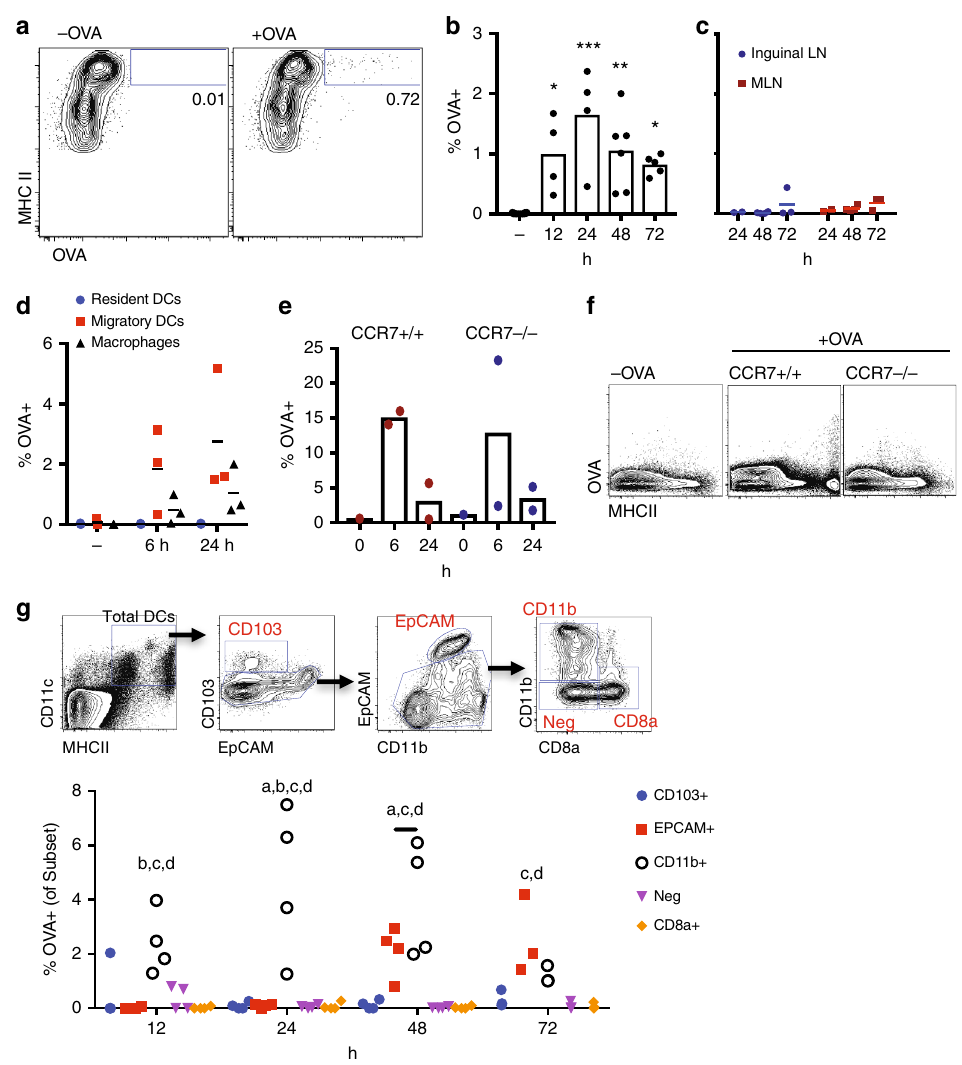
Fig. 2 Phenotype of DC subsets that are carrying OVA to skin-draining lymph nodes. a Gating in CD11c + MHCII + cells, representative plots of OVA + cells in the skin-draining (brachial) lymph nodes from Balb/c mice at 24 h after applying OVA AF647 . b Percentage of OVA + cells in CD11c + MHCII + cells from brachial lymph nodes ( b ) and distal inguinal and mesenteric lymph nodes (MLN) ( c ) at different time points. * p < 0.05, ** p < 0.01,*** p < 0.001 vs. no antigen. Kruskal – Wallis test with Dunn ’ s multiple comparison. d Frequency of OVA + migratory DCs (squares), resident DCs (circles), or macrophages (triangles). e Uptake of OVA in dermis of wild-type C57BL/6 or CCR7-/- mice. f Representative plots of OVA + cells in the brachial lymph nodes in wild- type C57BL/6 and CCR7 -/- mice, 48 h after applying OVA AF647 . Representative of three mice per group. g Frequency of OVA + DCs in each DC